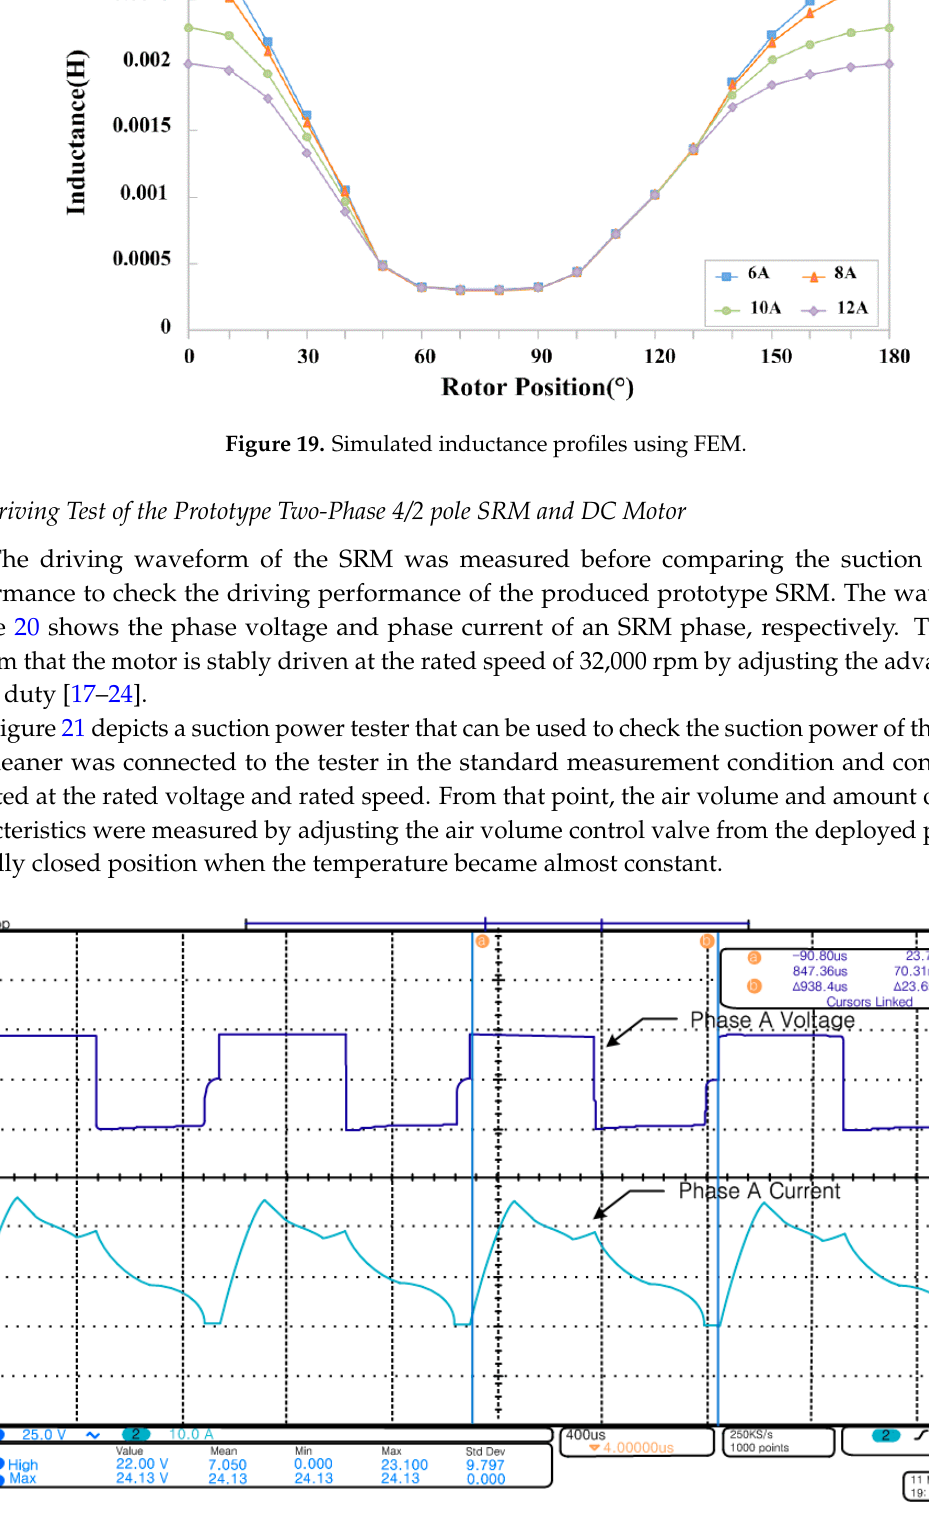
Figure 20. Operating waveform of prototype SRM.